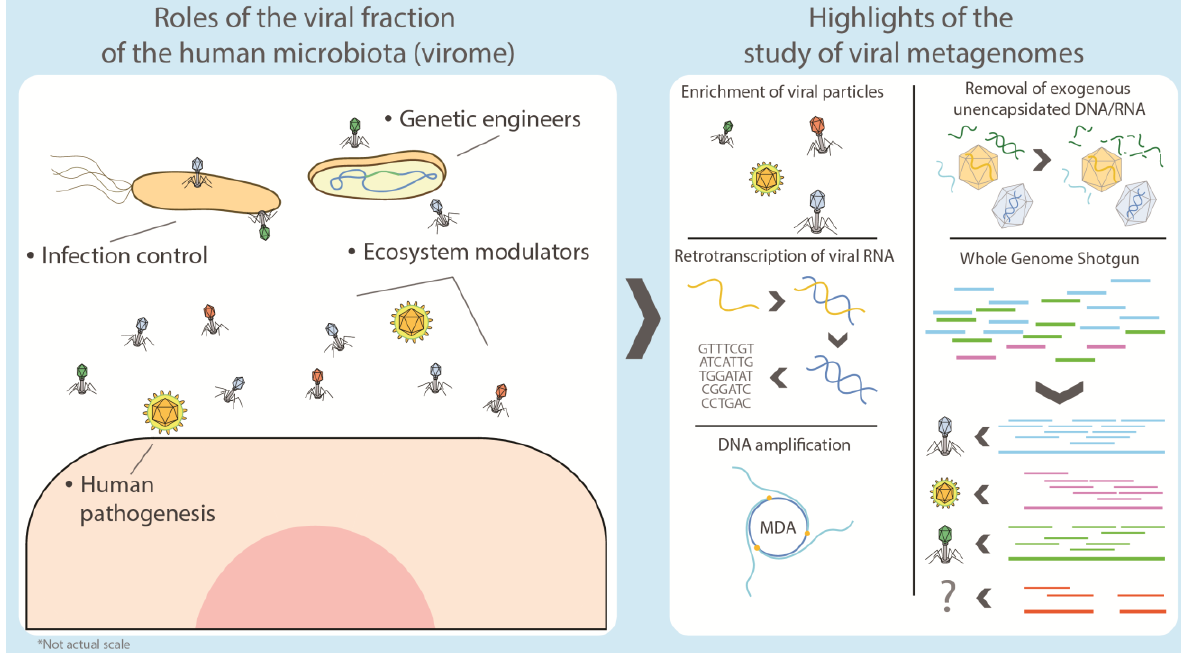
FIGURE 2: The study of the human virome. The viral fraction of the human microbiota (human virome) consists of thriving communities of viral particles, not restricted to human pathogens, but including bacteriophages and other eukaryotic viruses which actively contribute to the modulation of the ecosystem by stimulating the immune system and by directly infecting and even genetically altering certain microbi- al species and their genomes. Viromics, or the study of the virome and its critical impact the human host and its microbiota, relies on the isolation of such viral particles, the recovery (and amplification of their nucleic acids (multiple displacement amplification is shown) and, in the case of RNA viruses, an additional step consisting in the retrotranscription of their genomes to enable detection and sequencing. The subsequent analysis of the viral sequences depends on whole genome sequencing approaches. To this date, viromics is challenged with persistent methodological and conceptual biases and limitations that continue to be addressed with the advancement in the field of meta-